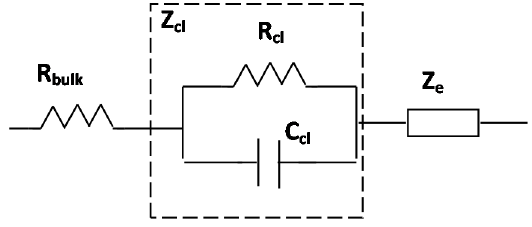
Figure 6. Simplified equivalent electrical circuit model of cell- substrate impedance (Z cl ) of biological cells. C cl is the capacitance of cell layer caused by dielectric properties of cell membrane, R cl is the resistance across cell layer including the cell-cell resistance of the gap between cells and cell-substrate resistance. R bulk is the resistance of bulk solution and the wire connection.